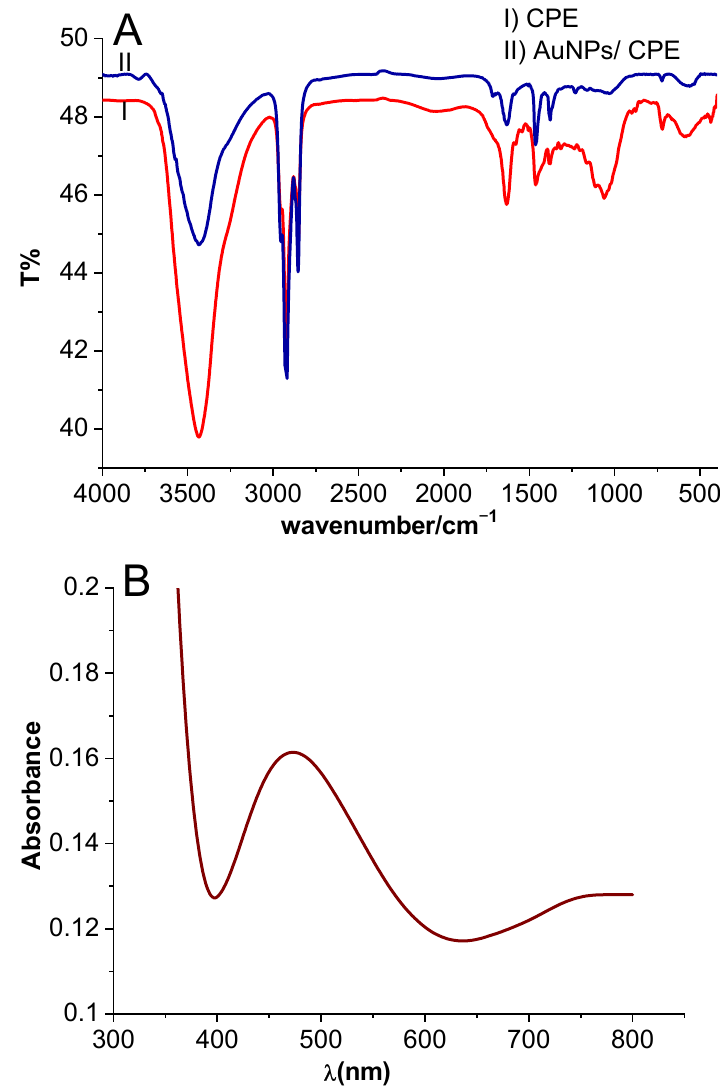
Figure 1. ( A ) FTIR spectra of the (I) CPE and (II) AuNPs/CPE. ( B ) UV–vis absorbance of AuNPs.